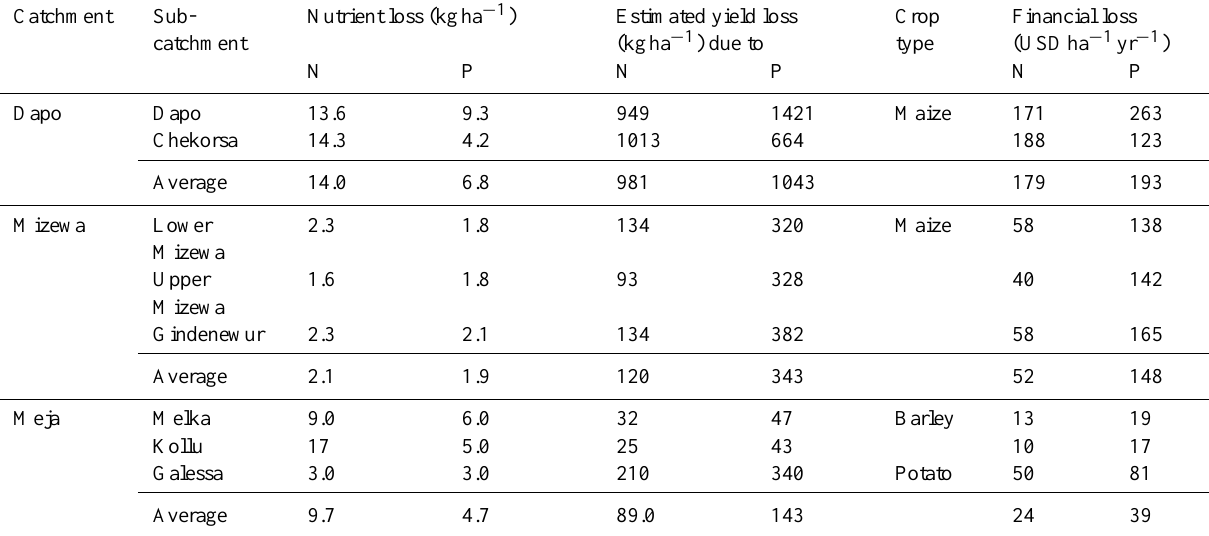
Table 5. N and P export with suspended sediment and dissolved in runoff during the season and the corresponding yield and financial loss (at an average exchange rate in February 2012 of 1 USD=19.89